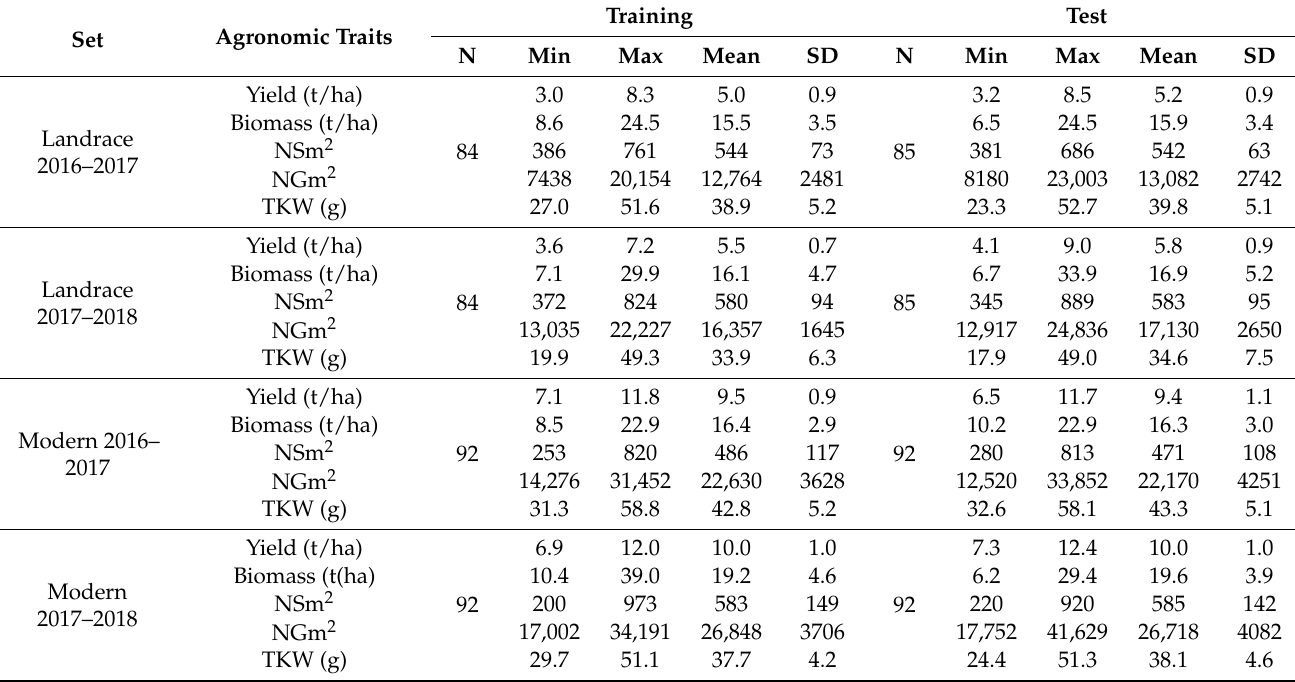
Table 4. Main descriptive statistics for yield (t/ha), biomass at ripening (t/ha), number of spikes per square meter (NSm 2 ),